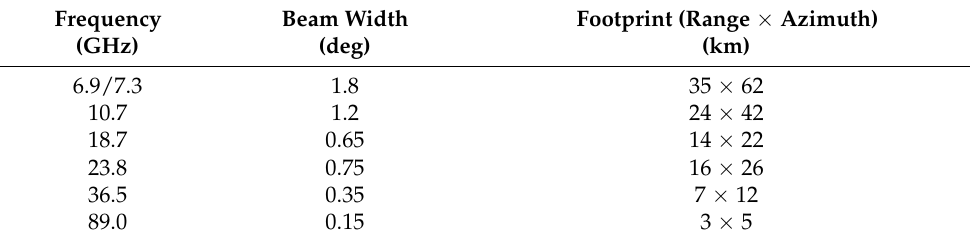
Table 1. AMSR2 instrument